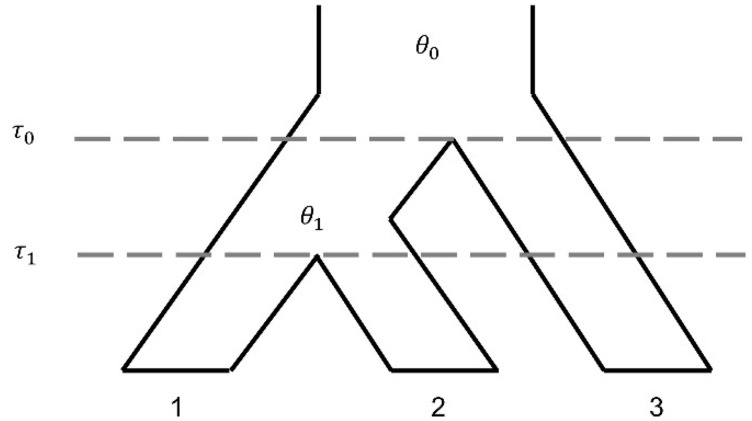
—Species tree ((1, 2), 3) for three species. The species divergence times are denoted as τ0 and τ1. The ancestral species population sizes are denoted as θ0 and θ1.